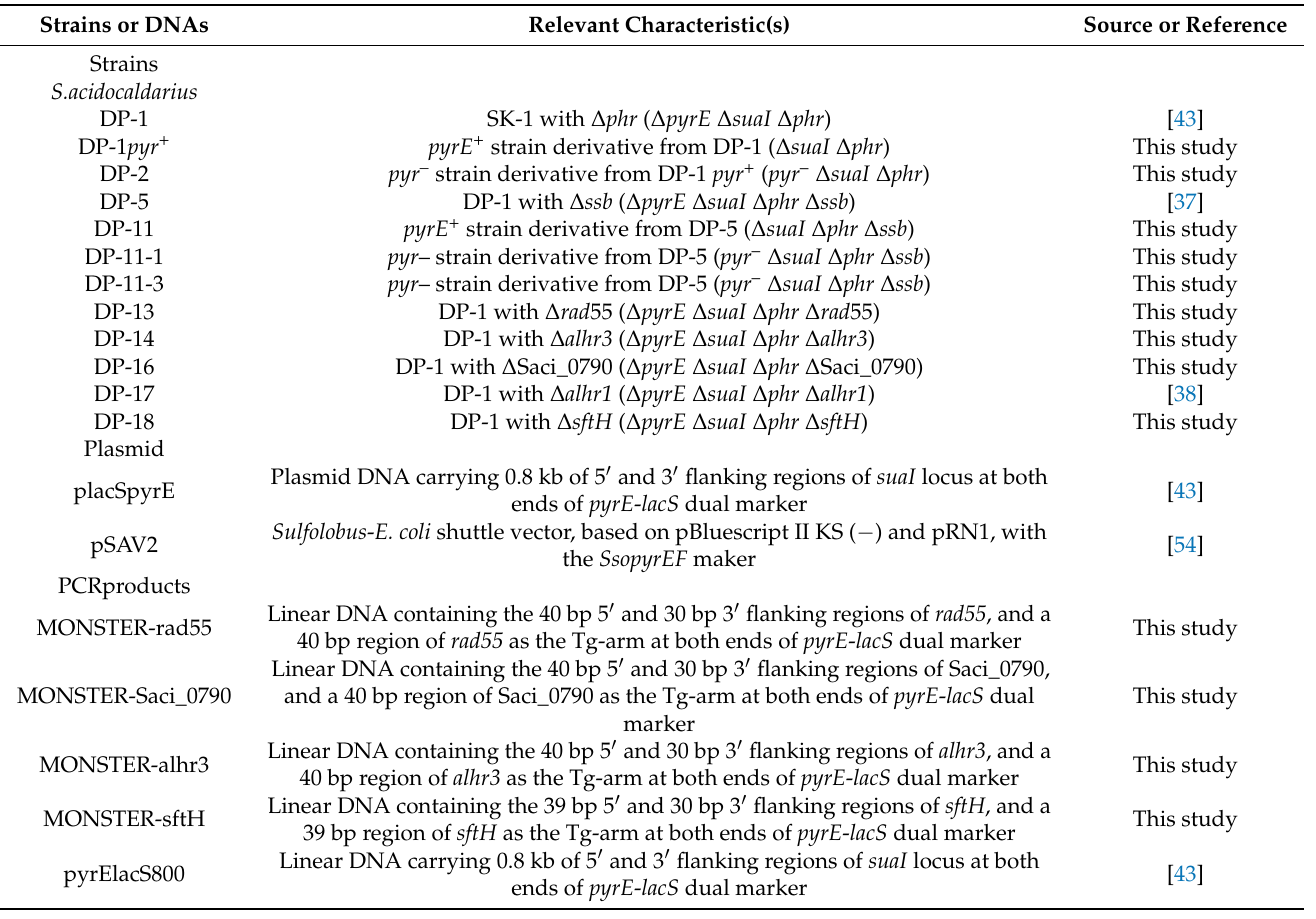
Table 2. Strains or DNAs used in this